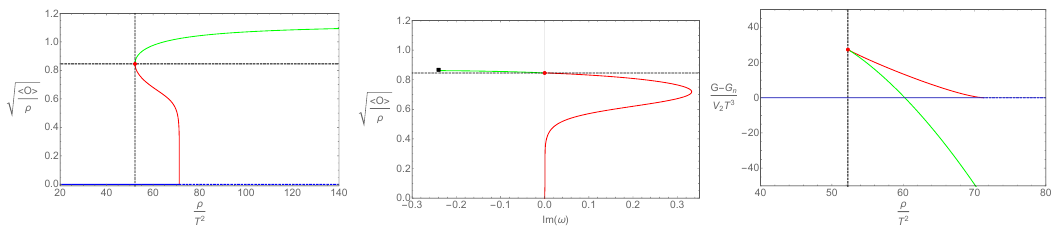
Figure 3 . A typical first order phase transition. Left : the normalized scalar condensate as a function of the dimensionless charge density. Middle : the imaginary part of the amplitude mode of the superfluid phase. Right : the Gibbs free energy difference between the normal phase and the superfluid phase. All figures are for λ = − 2 , τ = 0 . 8 and m 2 = − 2 , q = 1 . The red dot indicates the turning point. The black square denotes the position where the amplitude mode collide with another mode on the imaginary